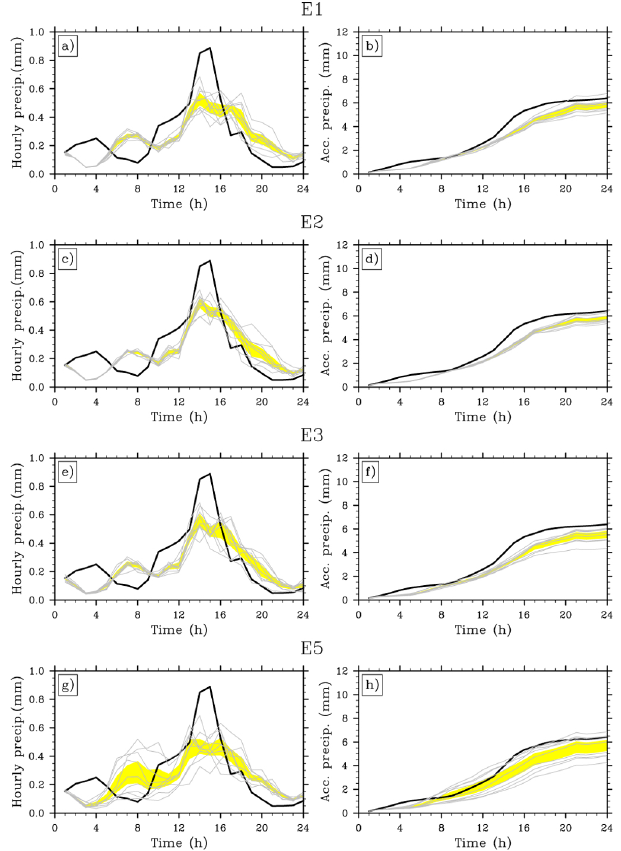
Fig. 8. Time evolution of the spatially averaged hourly-precipitation rate (left) and accumulated precipitation (right) for the ensembles E1, E2, E3, and E5 (Gard-H´erault case). The ensemble members are shown in grey and the observations in black. Yellow shading corresponds to the standard deviation from the ensemble mean.